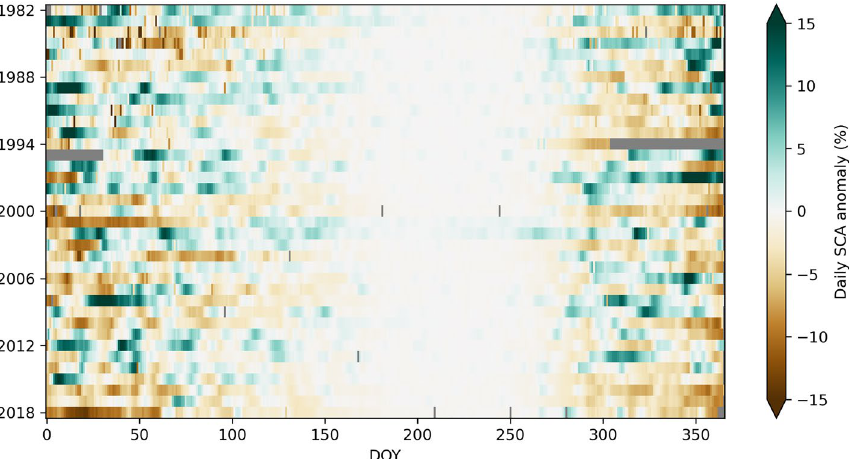
Figure 5. Long-term seasonal snow cover variability in the HKH. Heat map of daily SCA anomalies over the study period 1982–2018 with respect to the 1982–2010 reference period. Missing data from November 1994 to February 1995, and some individual days, are marked in